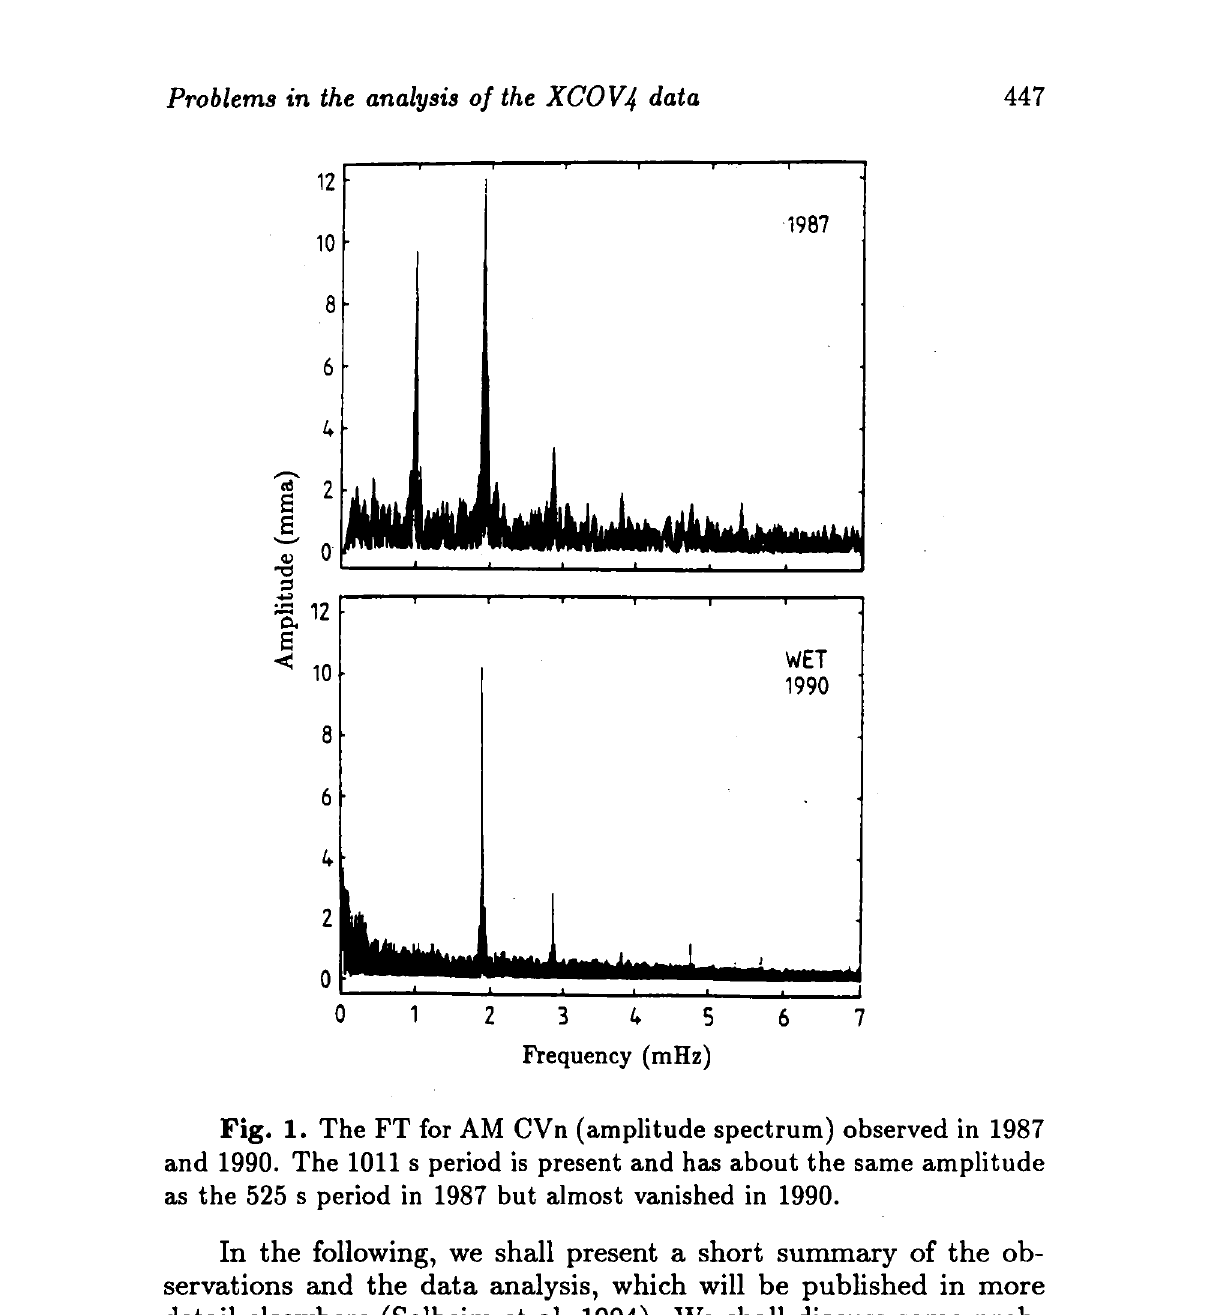
Fig. 1. The FT for AM CVn (amplitude spectrum) observed in 1987 and 1990. The 1011 s period is present and has about the same amplitude as the 525 s period in 1987 but almost vanished in